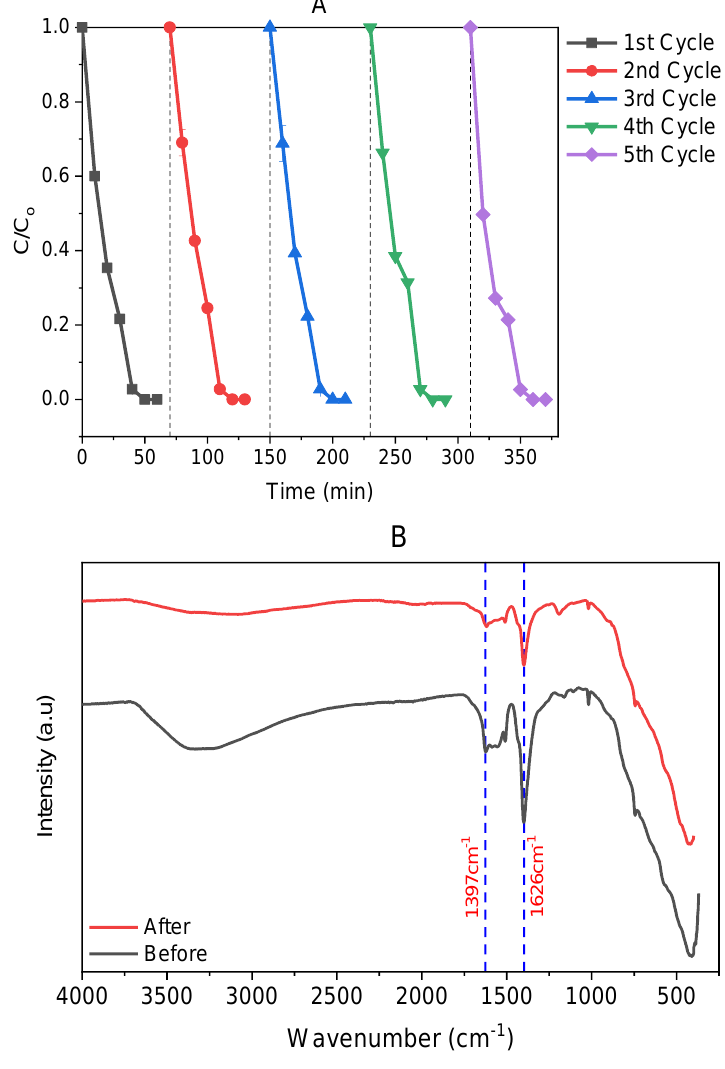
Figure 12. ( A ) Recycle experiments of MIL − 101(Cr)@TiO 2 composite for CBZ degradation. ( B ) FTIR spectrum of MIL − 101(Cr)@TiO 2 ; black: Virgin, red: after 5th cycle.